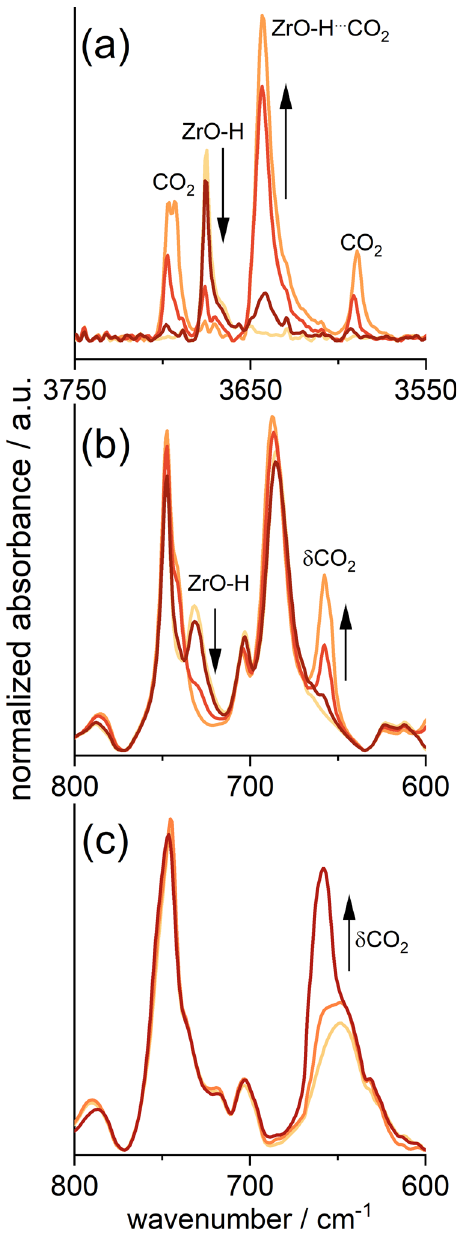
Fig. 7 IR spectra of carbon dioxide adsorbed in UiO-66_220. a The range of OH groups, b the range of skeletal vibrations, both for sample activated at 100 °C; c the range of skeletal vibrations for sample activated at 300